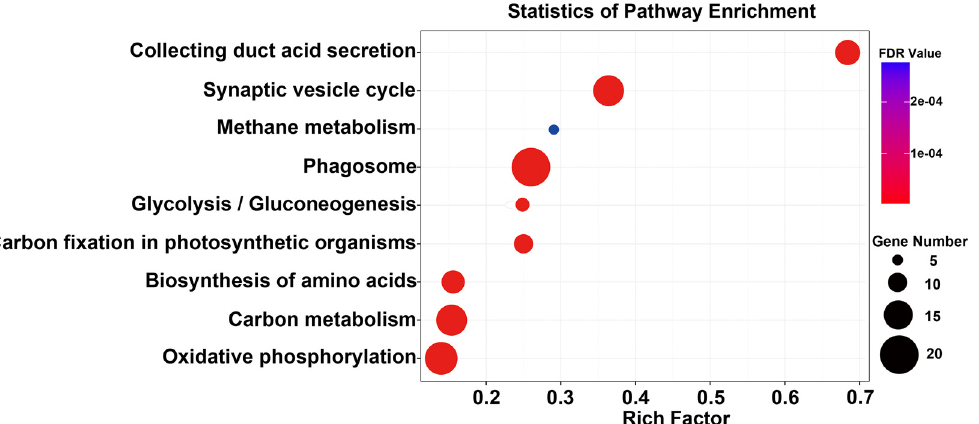
Fig 5. Scatter plot of enriched KEGG pathways for the 282 up-regulated genes in the ASG. The “ rich factor ” shows the ratio of the number of the up- regulated genes to the total gene number in certain pathways. All pathways had FDR (cid:3)